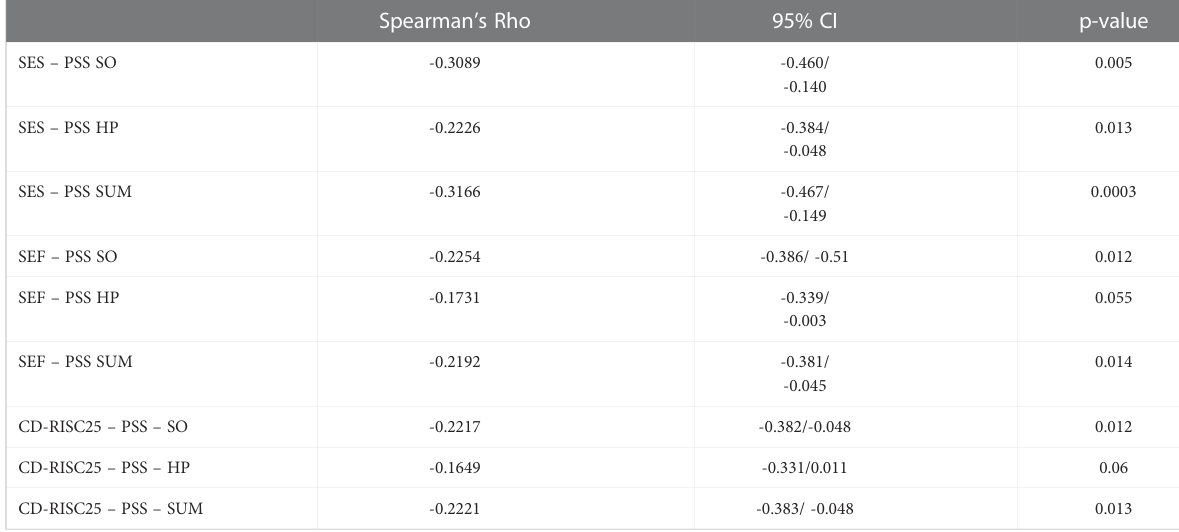
TABLE 3 Correlations between SES, SEF, CD-RISC25 and